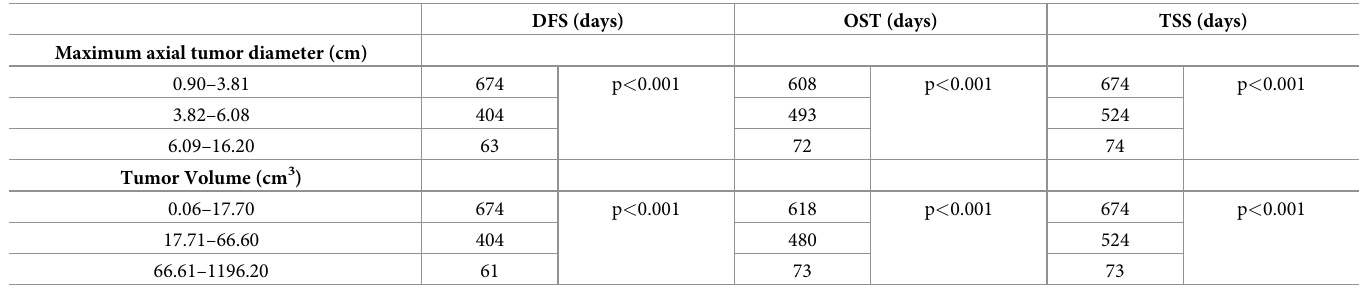
to each other and to both longest tumor diameter and volume (S1 Table). Table 4. Outcome parameters for dogs with lung tumors based on maximum tumor diameter and volume. DFS